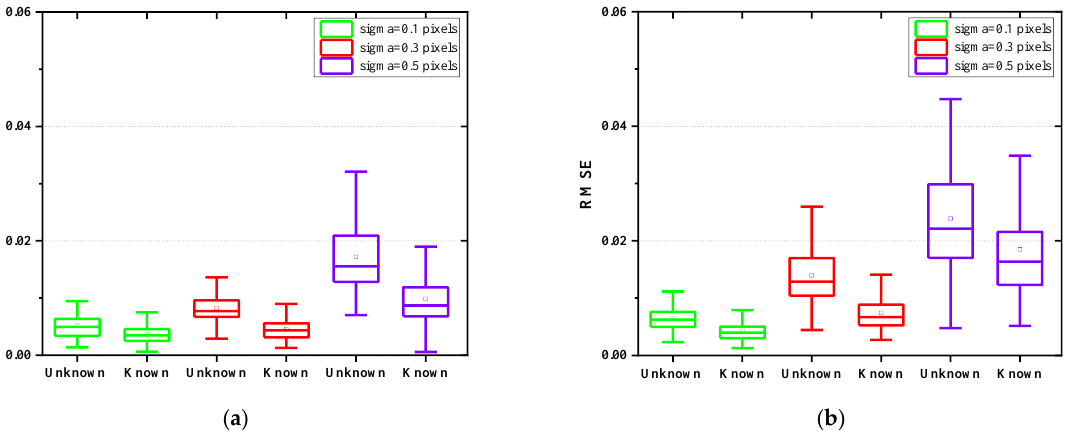
Figure 9. Comparison between the case where the sigma is known and the case where the sigma is unknown for a low SNR ( a ) and a high SNR ( b ). For a high SNR, the accuracy of phase retrieval in the two cases is comparable. For a low SNR, the accuracy of phase retrieval in the case where the sigma is unknown is much lower than in the case where the jitter magnitude is